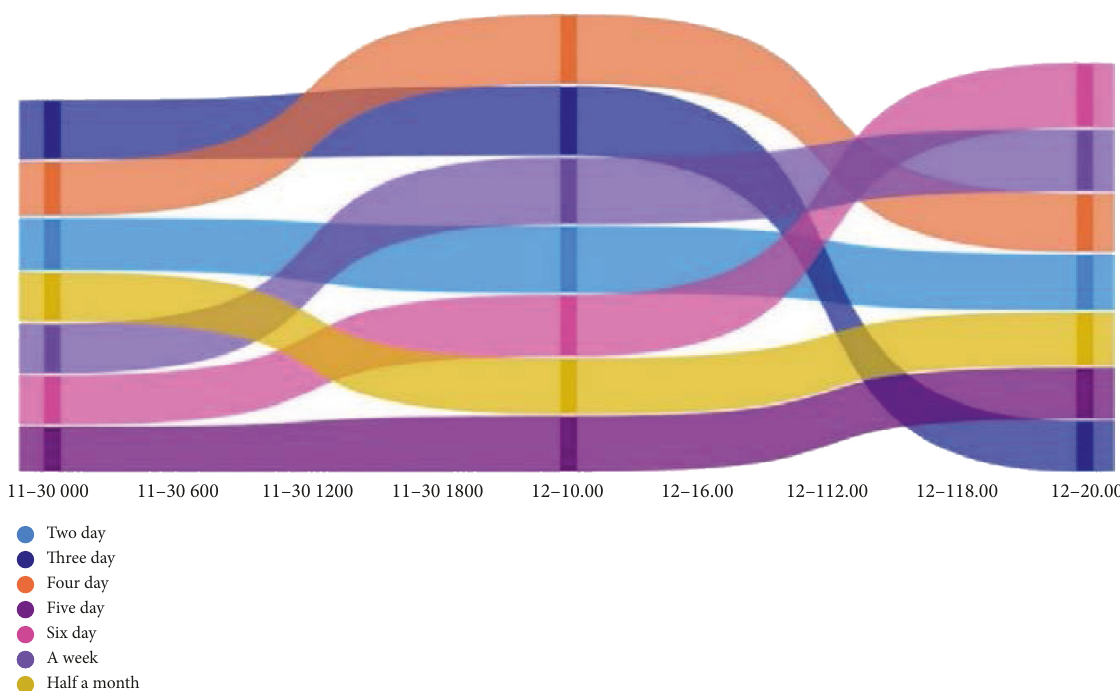
Figure 18: Payment rates of different mobile phone brands.